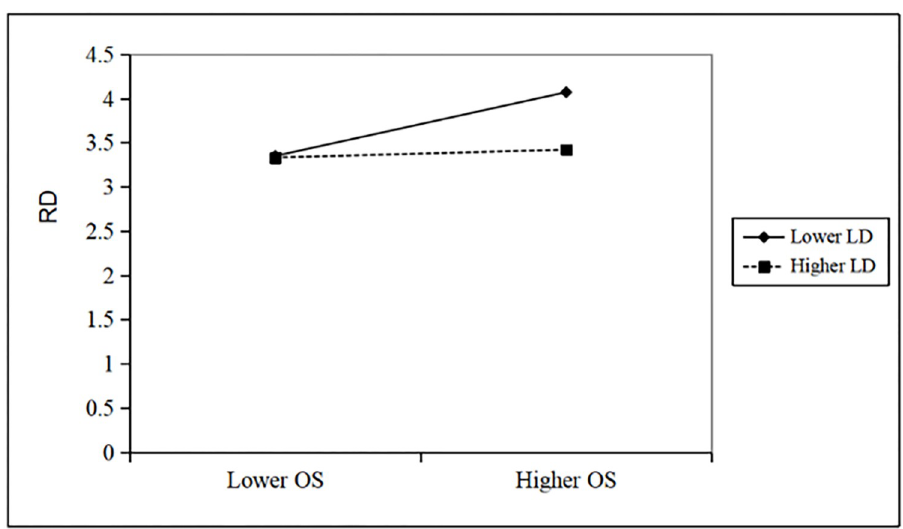
Fig 4. The moderating effect of executive